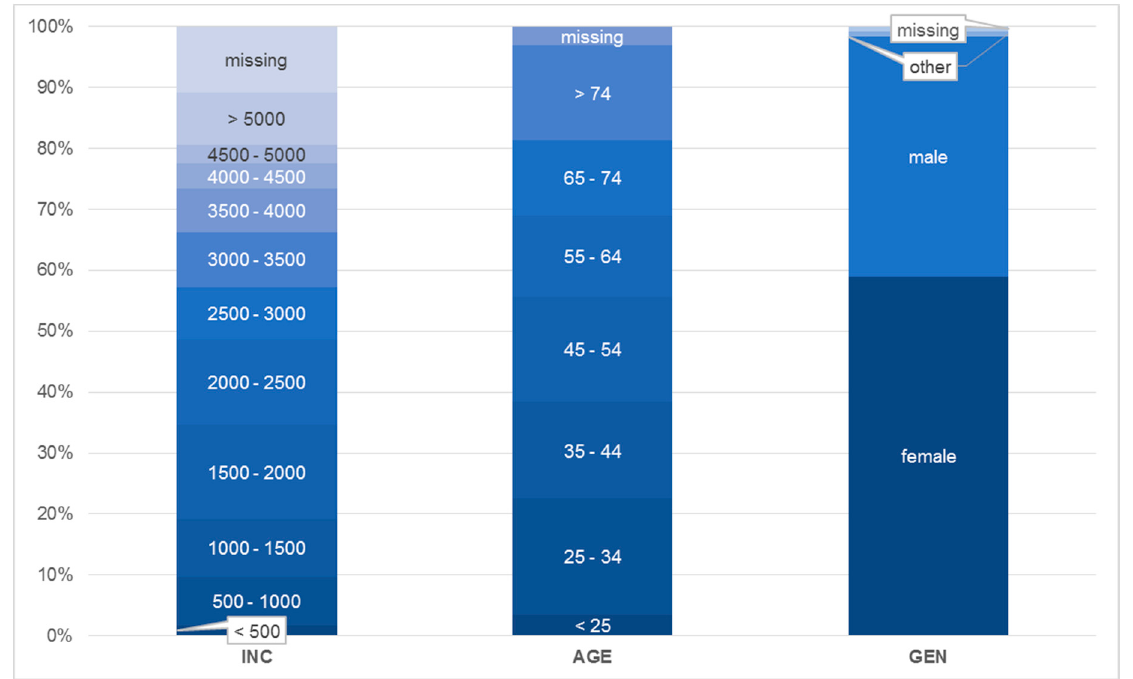
Figure 5. Distribution of income, educational classes and gender in the sample.